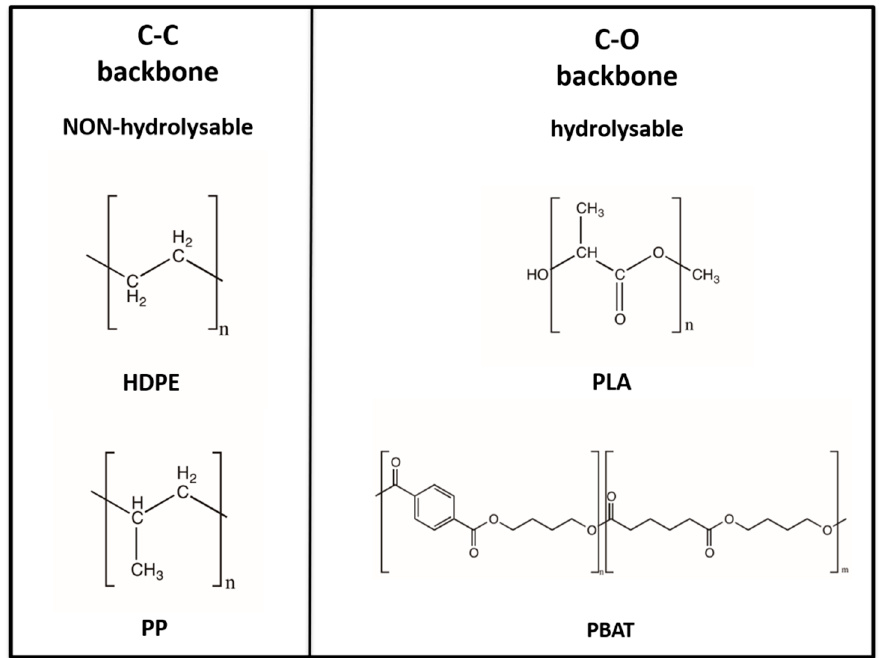
Figure 8. Classification of HDPE, PP, PLA and PBAT based on chemical backbone